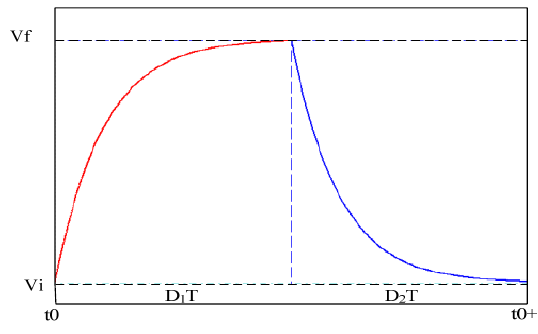
Figure 3. In the duty cycle, T is fixed, and D1 and D2 are set to 50%; we can describe the shuttling process like this: